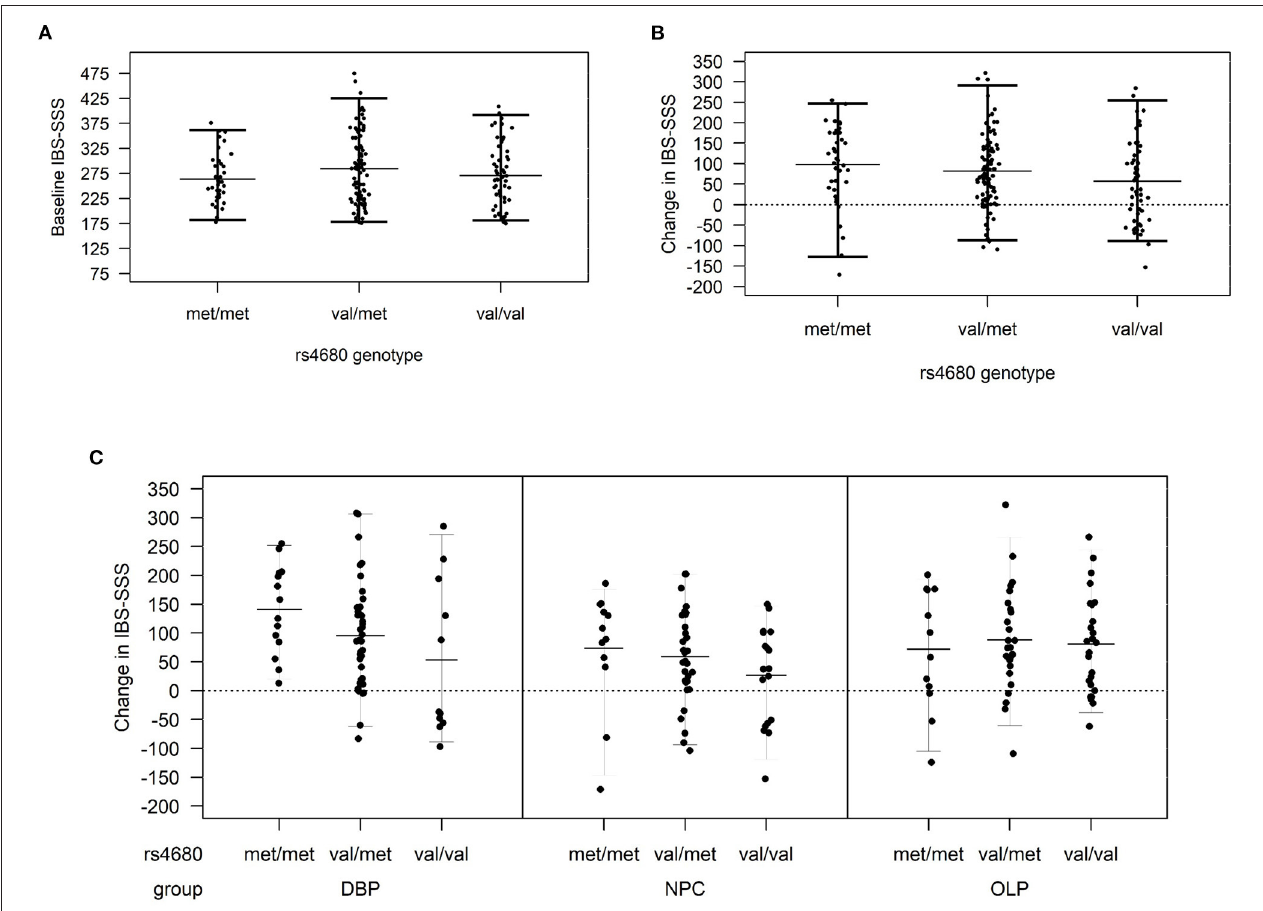
FIGURE 1 | (A) Baseline irritable bowel symptom severity score (IBS-SSS) by COMT genotype across all treatment arms, (B) change in IBS-SSS by COMT rs4680 genotype overall, and (C) by treatment arm (DBP, double-blind; OLP, open-label and NPC, no-pill